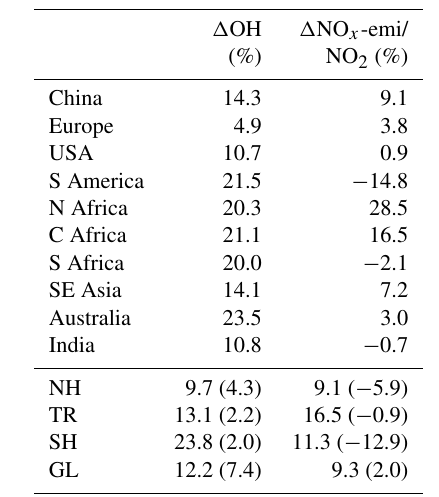
Table 6. Regional and 10-year mean difference in lower tropo- spheric OH concentration averaged below 790hPa ( (cid:49) OH) and the ratio of surface NO x emission and lower tropospheric NO 2 con- centration averaged below 790hPa ( (cid:49) NO x -emi/NO 2 ) between the data assimilation run and the model simulation in the boreal sum- mer (averaged over June–August) over the 2005–2014